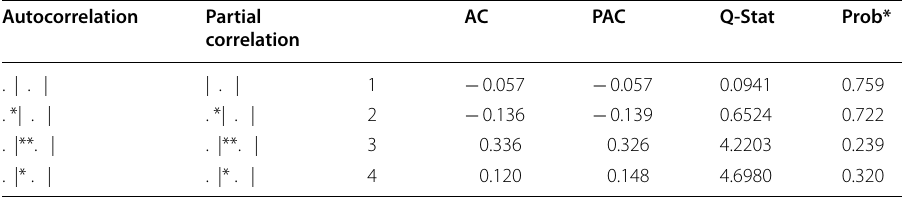
Source: authors’ estimation from UNDP, WDI, and ETH Zurich KOF data *Probabilities may not be valid for this equation specification